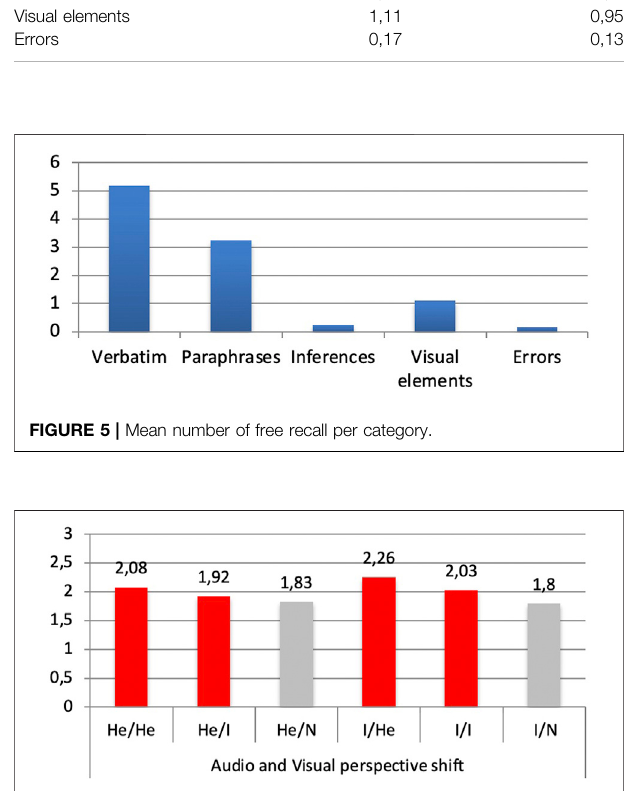
FIGURE6| MeannumberoffreerecallpercategoryaccordingtheAudio and Visual perspective shift (e.g., He/I = no audio shift in perspective combined with visual shift in